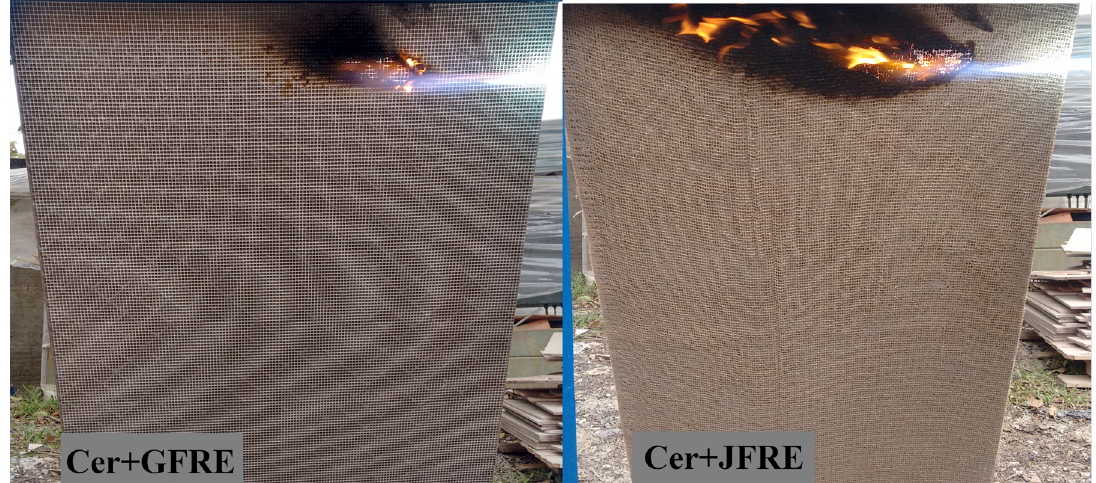
Figure 9. Initial moments in the flame propagation test.